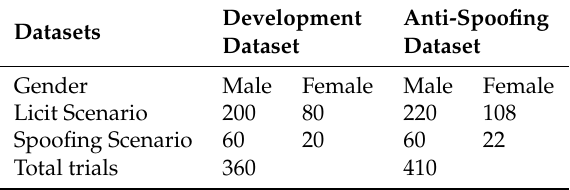
Table 1. Datasets collected for different scenarios.